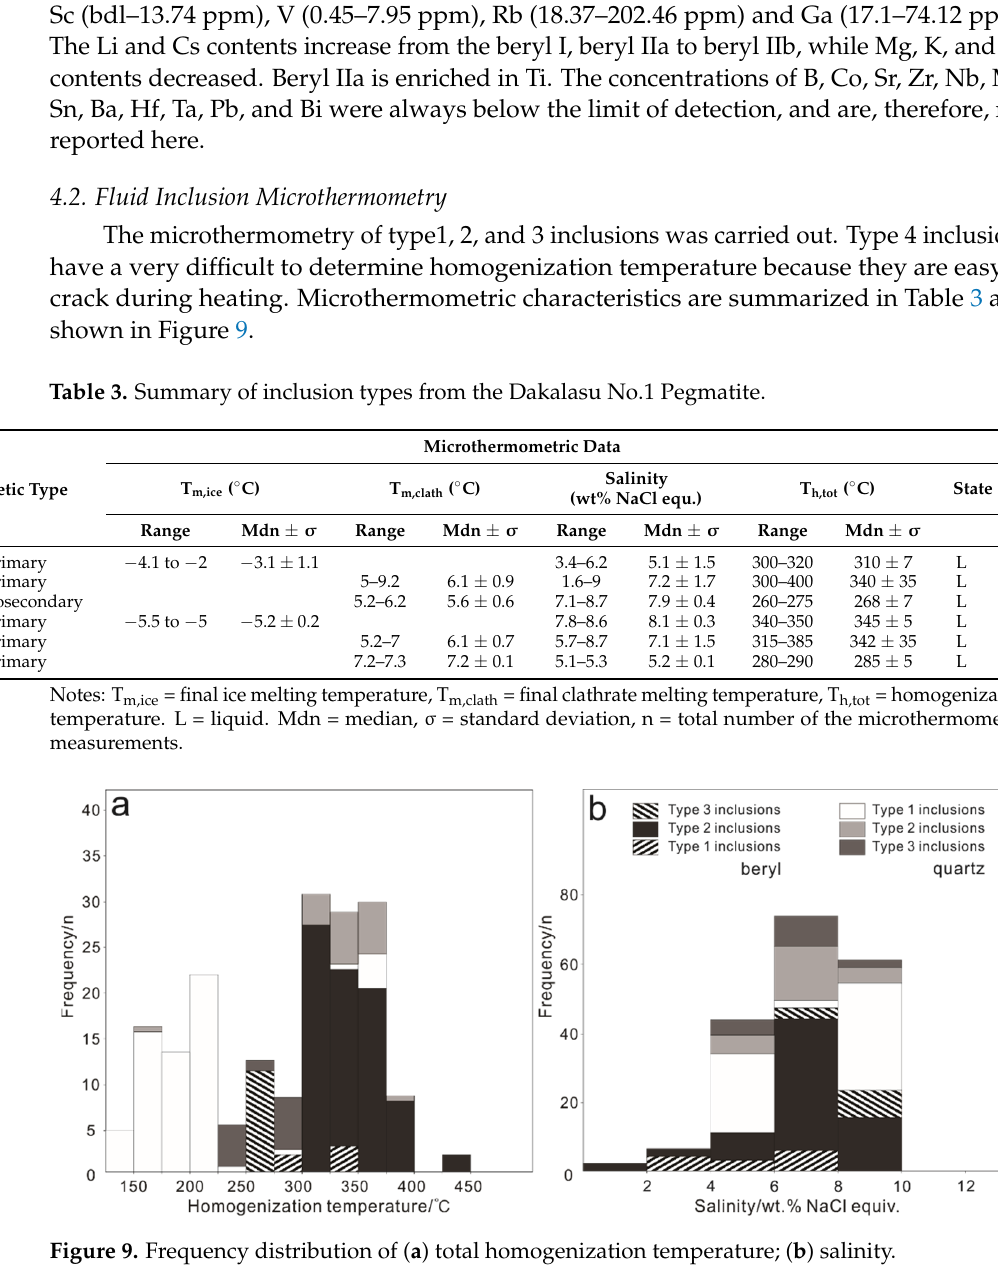
Table 3. Summary of inclusion types from the Dakalasu No.1 Pegmatite.